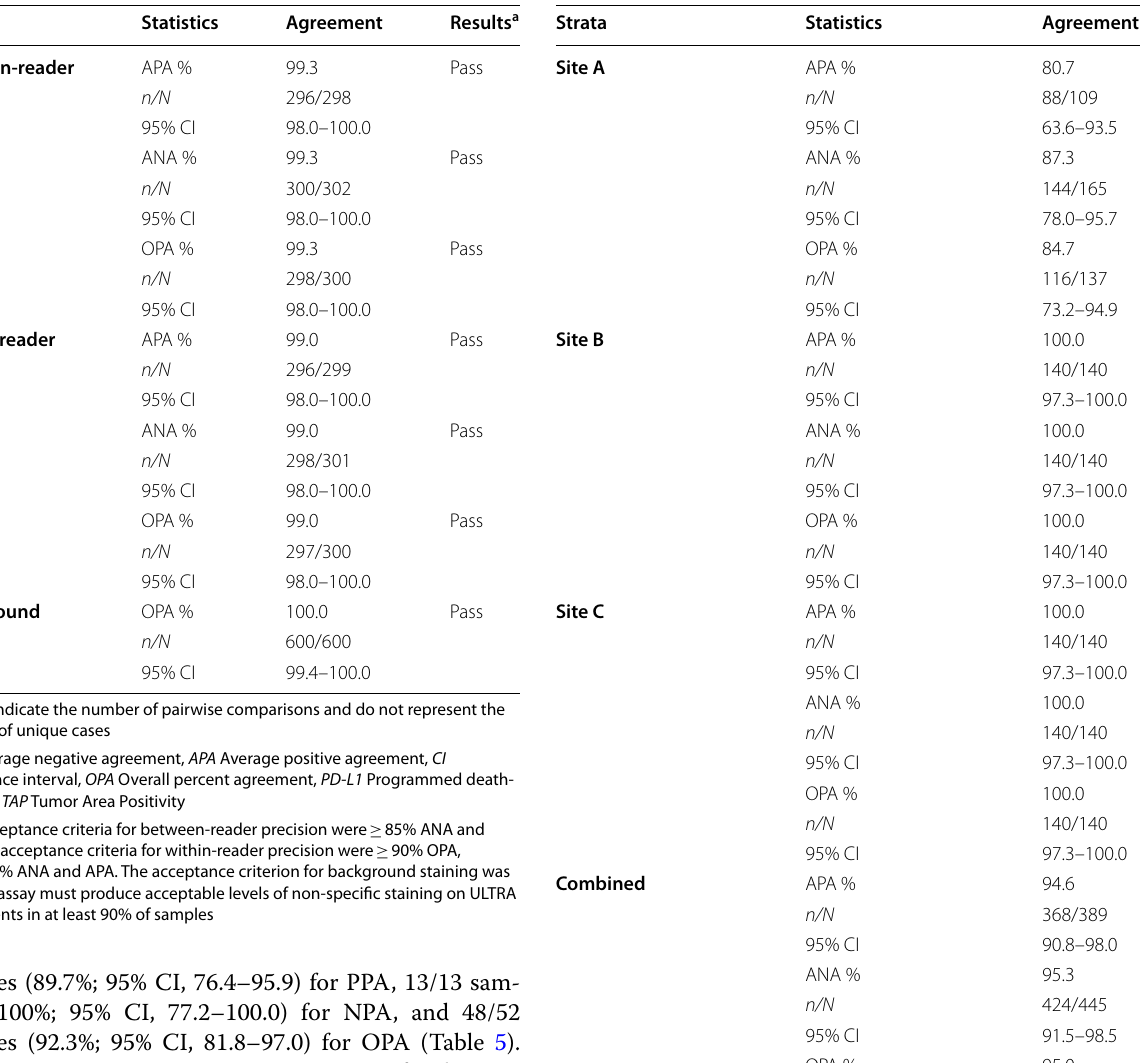
Table 3 TAP scoring precision for determining PD-L1